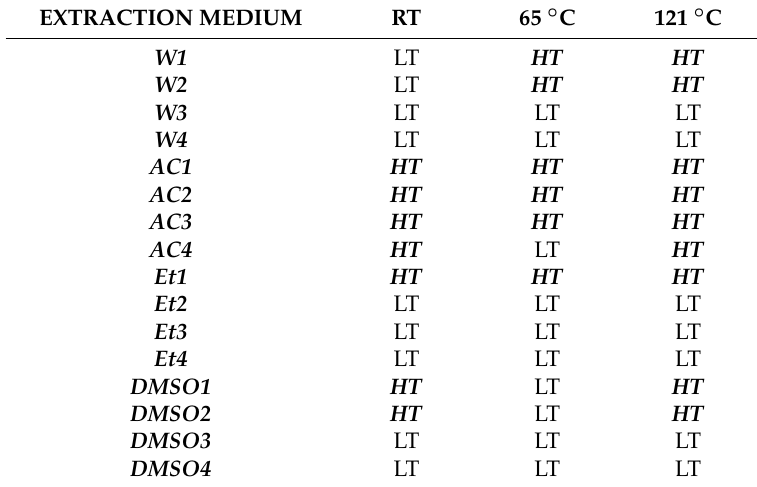
Table 2. Toxicity expertise for extraction media and temperature